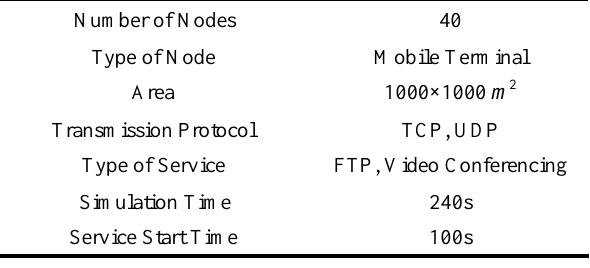
Table 2. Table 2 Simulation parameters for MANET